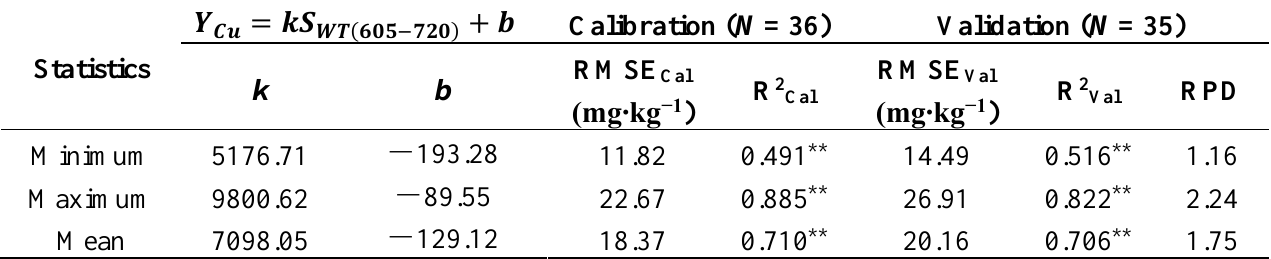
Table 3. Calibration and validation results of estimating foliar Cu concentration based on 1000 random dataset partitioning experiments.